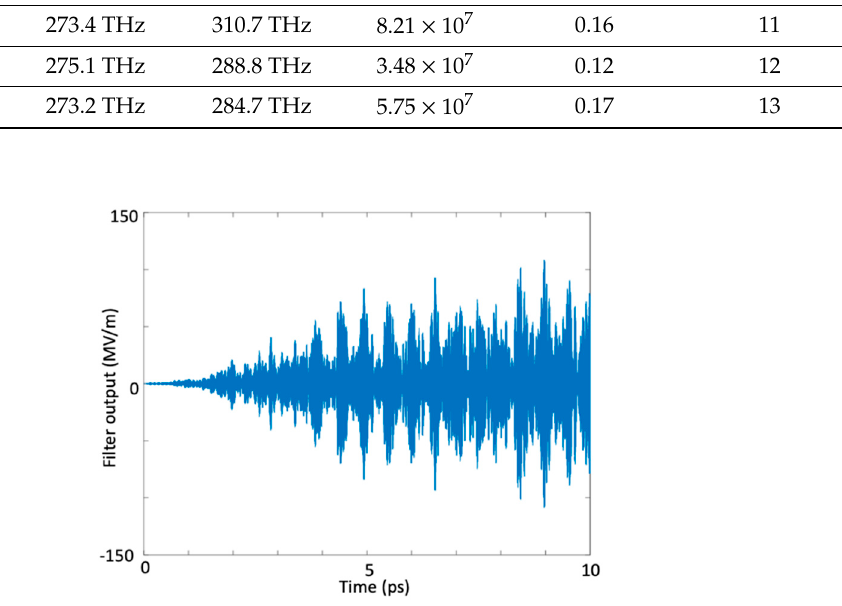
Figure 4. Time variation of the maximum electric field amplitude at the bandpass filter output (820 THz).